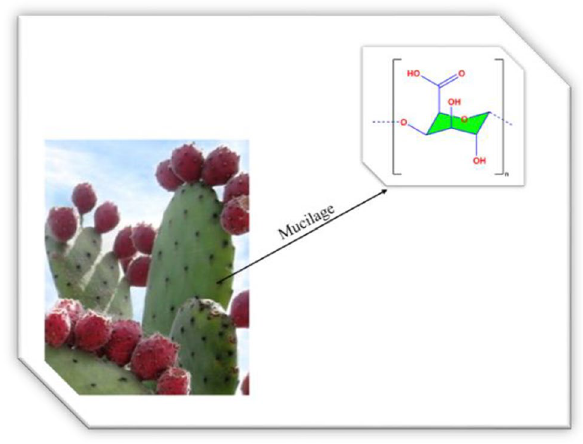
Fig. 19 P. Vulgaris seed protein as coagulant